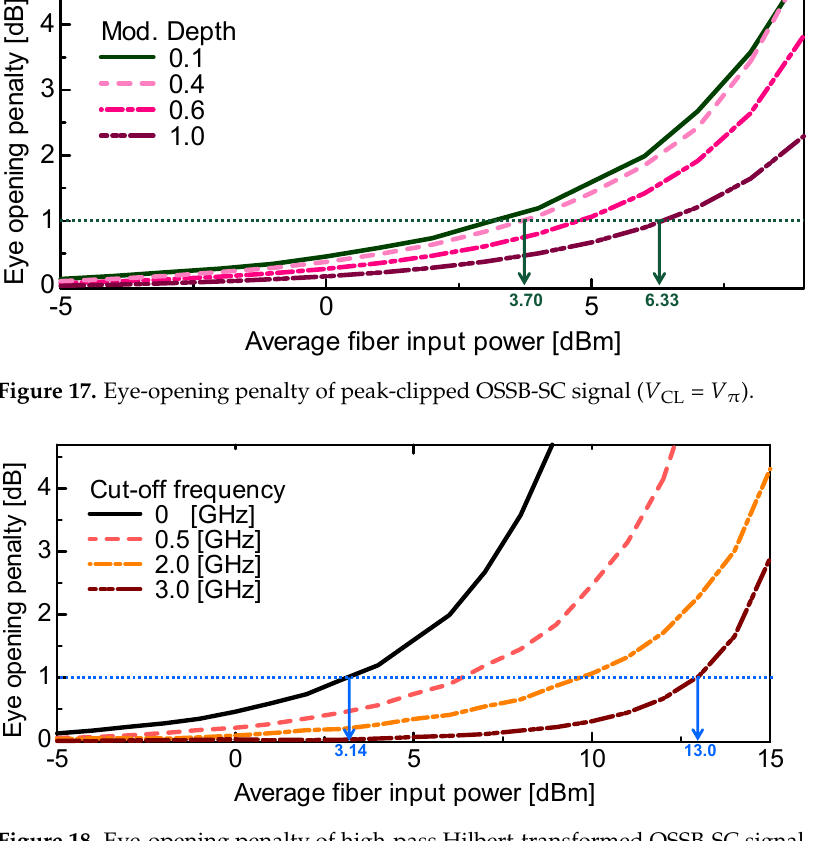
Figure 18. Eye-opening penalty of high-pass Hilbert-transformed OSSB-SC signal.